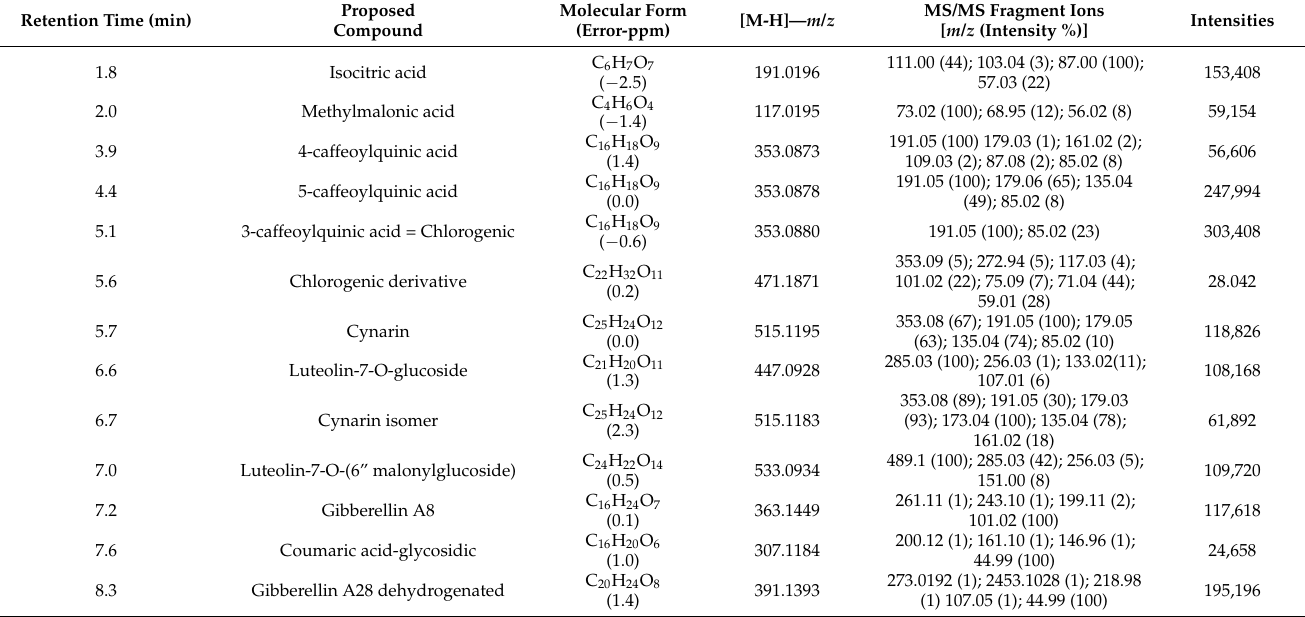
Table 1. Characterization of compounds present in leaves decoction extract of C. cardunculus L. by HPLC-DAD-ESI (Negative mode)